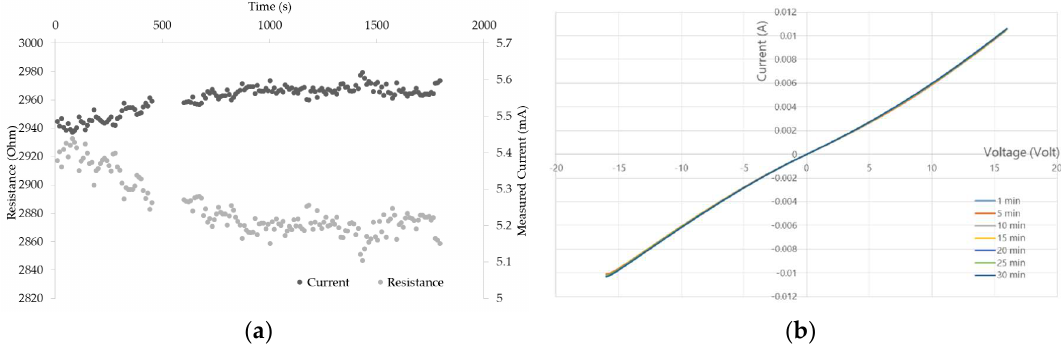
Figure 12. Measured current and resistance as a function of test time for adhesive B on an OSP test board ( a ) and cycle sweeps ( b ).